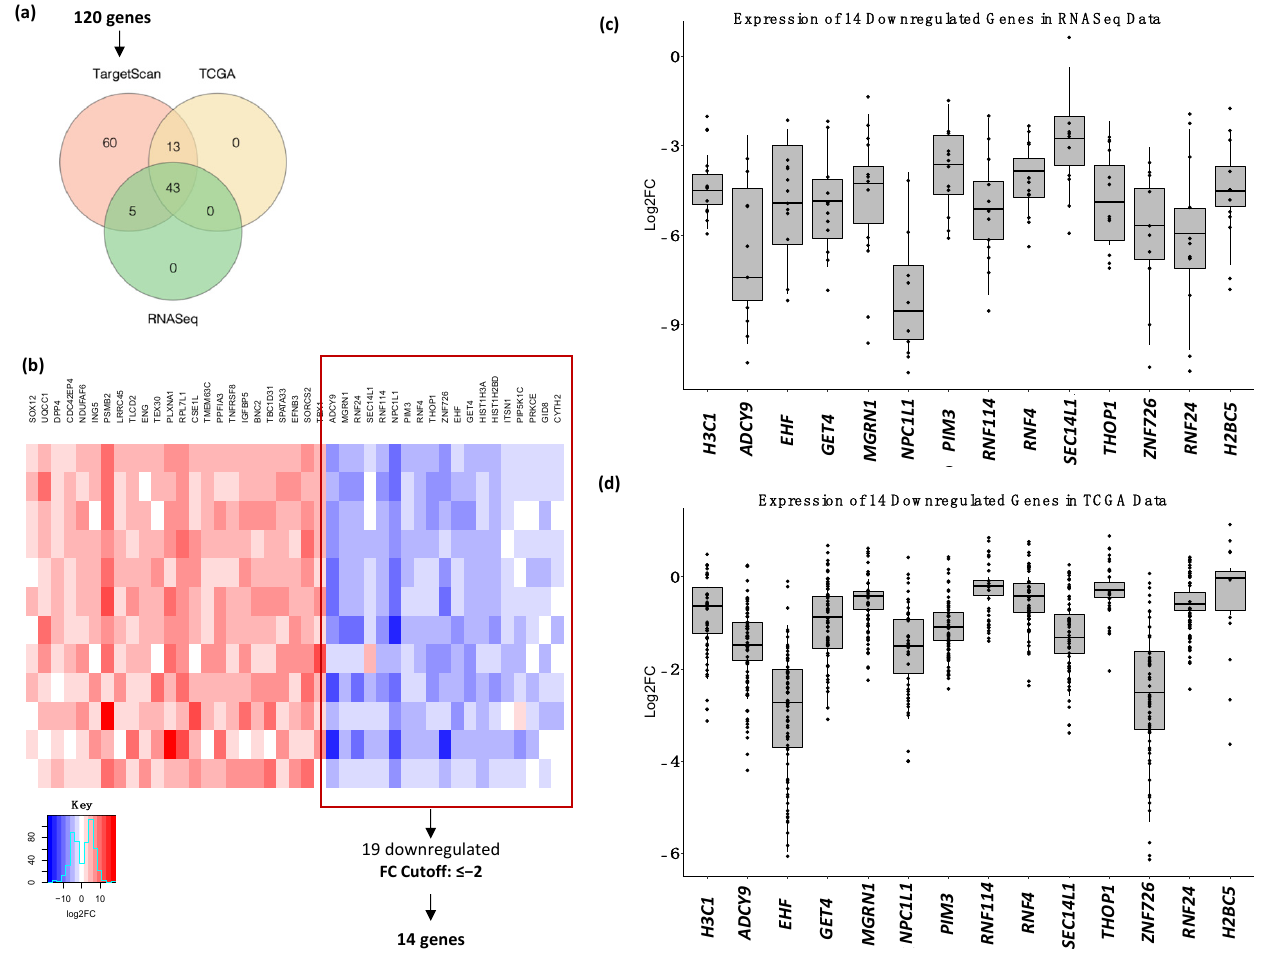
RNF4 , ZNF726 , GET4 , and RNF114 , with predicted relative KD values of − 2.017, − 3.493, Expression of 14 Dow nregulated G enes in RN ASeq Data